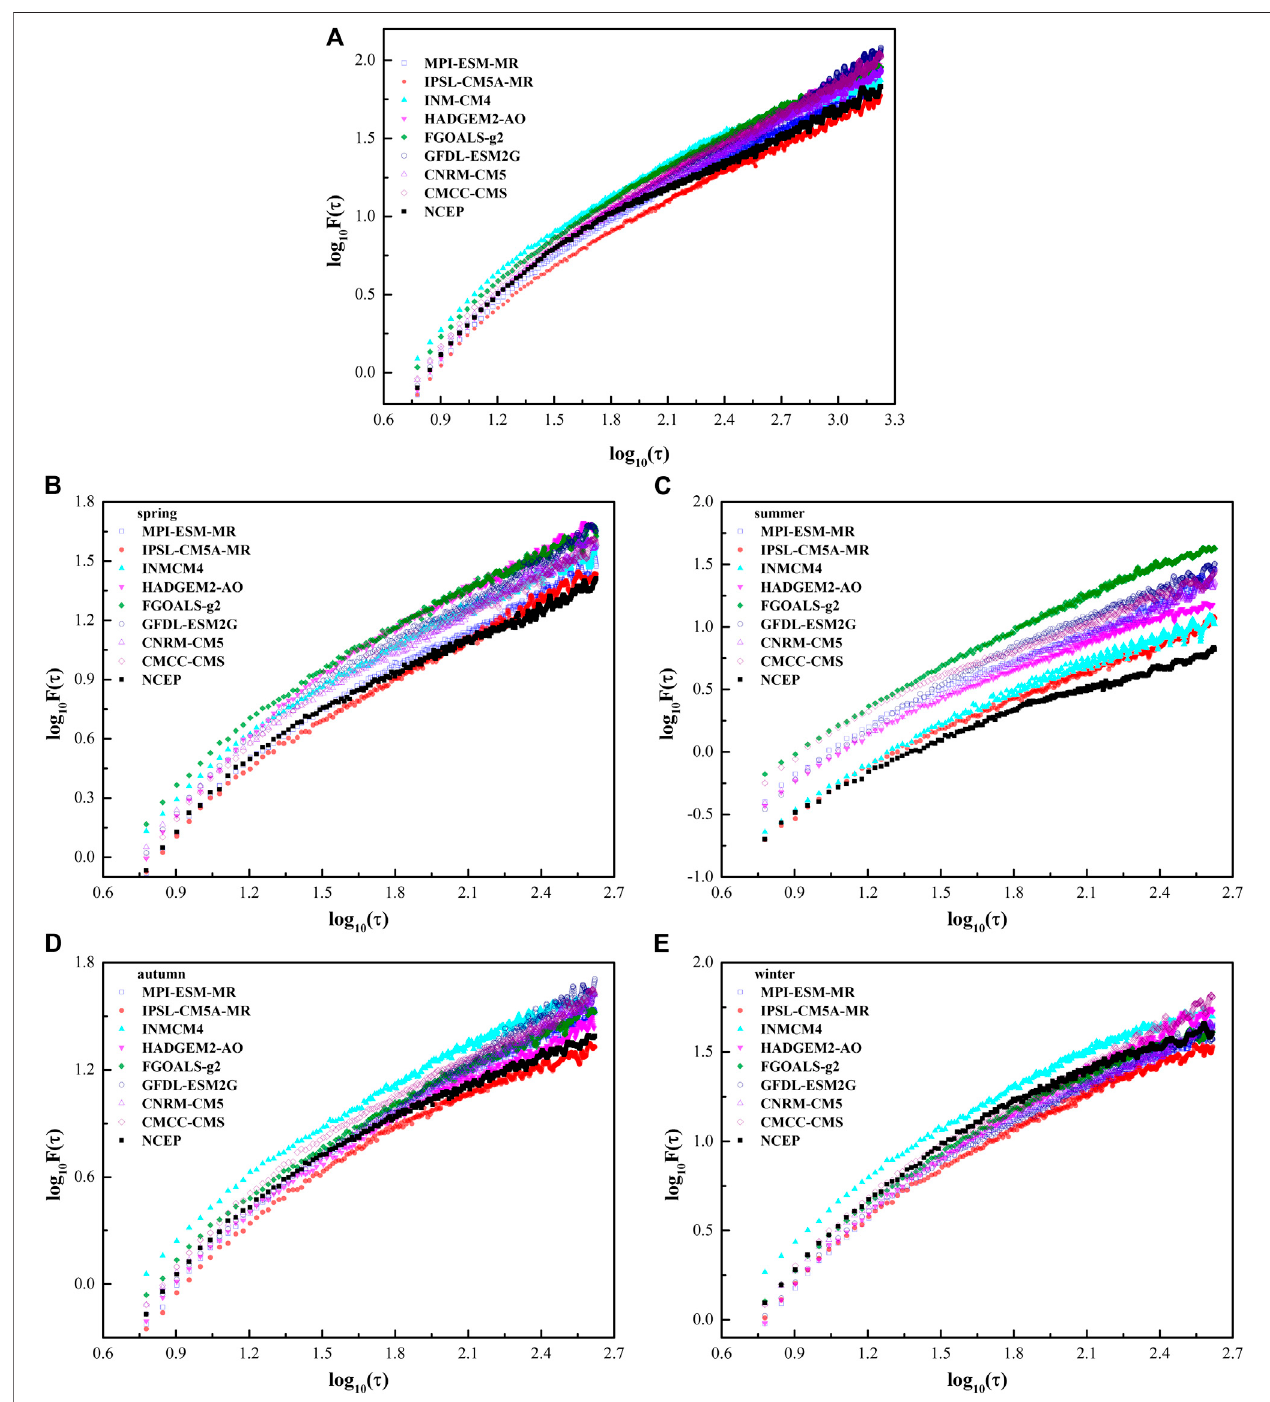
FIGURE 2 | The DFA2 results of SAT from NCEP and CMIP5 models at the point of (110 ° E, 23 ° N) for (A) year, (B) spring, (C) summer, (D) autumn, and (E) winter.